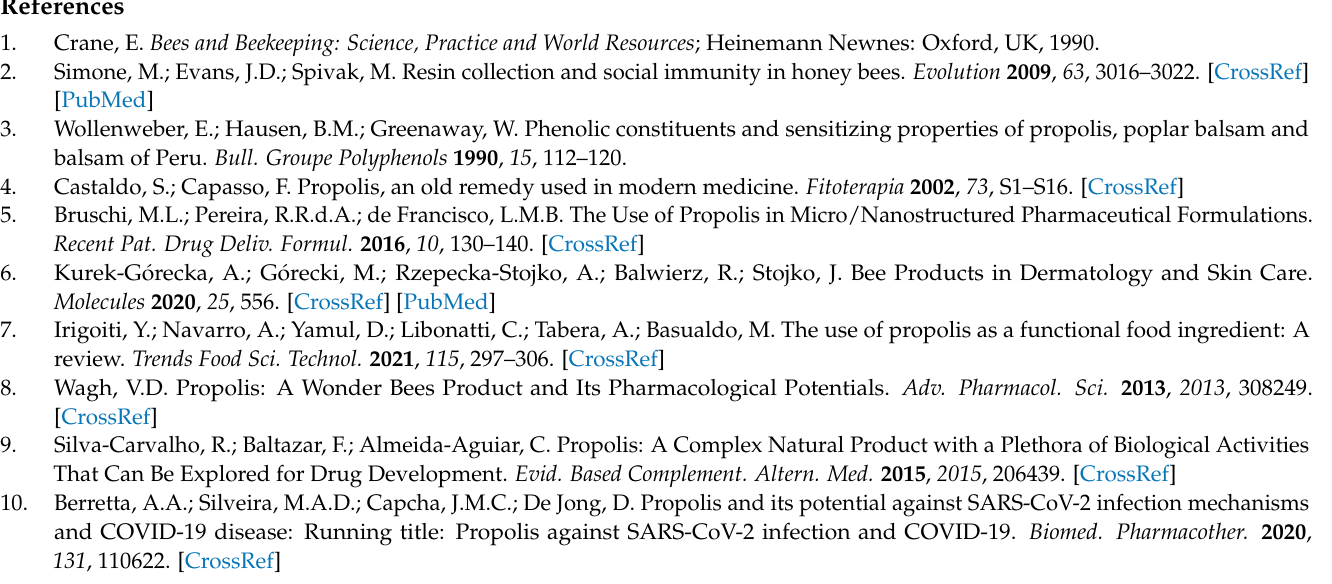
H- 1 H COSY, HSQC, HMBC and NOESY spectra of 2 in CDCl 3 ; Figure S4. HRESIMS spectrum of 3 ; Figure S5. 1 H NMR, 1 H- 1 H COSY, HSQC, HMBC and ROESY spectra of 3 in CDCl 3 ; Figure S6. 1 H NMR, 13 C NMR, DEPT, 1 H- 1 H COSY, HSQC, HMBC and ROESY spectra of 4 in CDCl 3 ; Figure S7. 1 H NMR, 13 C NMR, HSQC and HMBC spectra of 4 in acetone- d 6 ; Figure S8. HSQC, HMBC and ROESY spectra of 5 in CDCl 3 ; Figure S9. 1 H NMR, 13 C NMR, HSQC, HMBC and ROESY spectra of 5 in acetone- d 6 ; Figure S10. 1 H NMR spectrum of 6 in CDCl 3 ; Figure S11. 1 H NMR spectrum of 7 in CDCl 3 ; Figure S12. 1 H NMR spectrum of 8 in CDCl 3 ; Figure S13. 1 H NMR